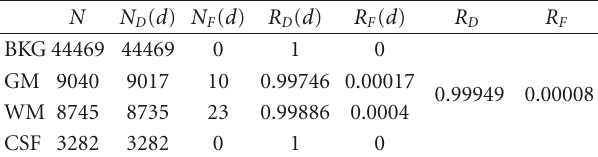
Table 5: Assessment results of FCM (10dB) N